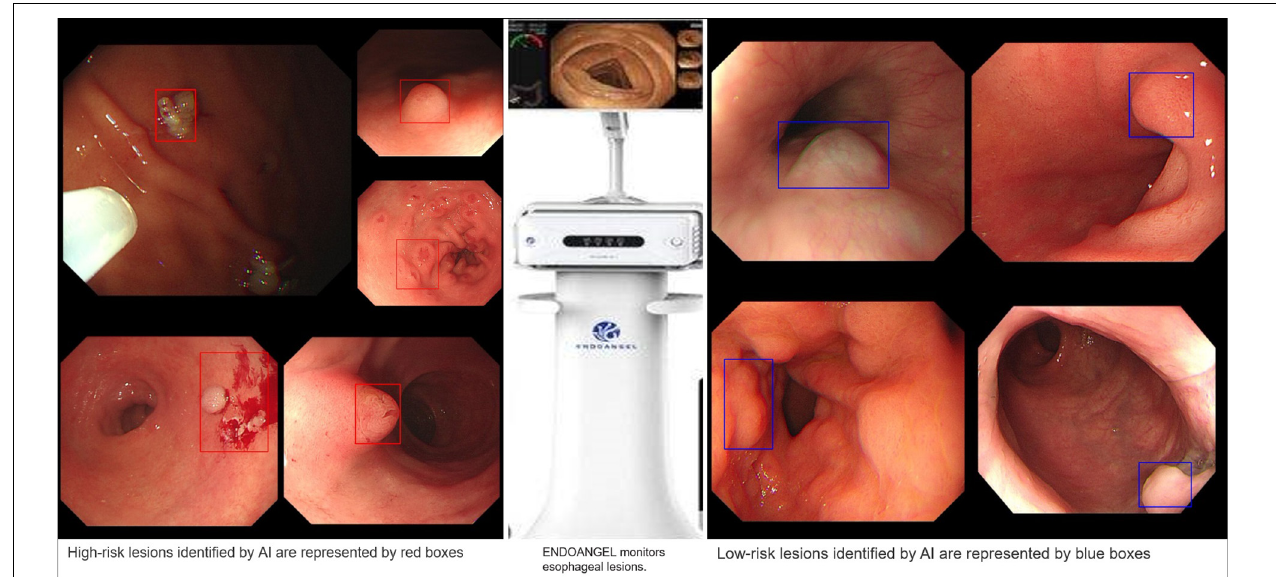
FIGURE 11 | EndoAngel-assisted endoscopy. The image on the left shows high-risk lesions, and the image on the right shows low-risk lesions. During endoscopy, AI automatically identified and evaluated the lesion. If it detected a high-risk lesion, a red prompt box appeared, while a blue prompt box appeared for low-risk lesions. The prompt box not only helps the endoscopist quickly identify the lesion but also helps doctors carry out an accurate sampling biopsy. of GI tumor lesions; in addition, it is also equipped with a scoring training system for upper and lower gastrointestinal